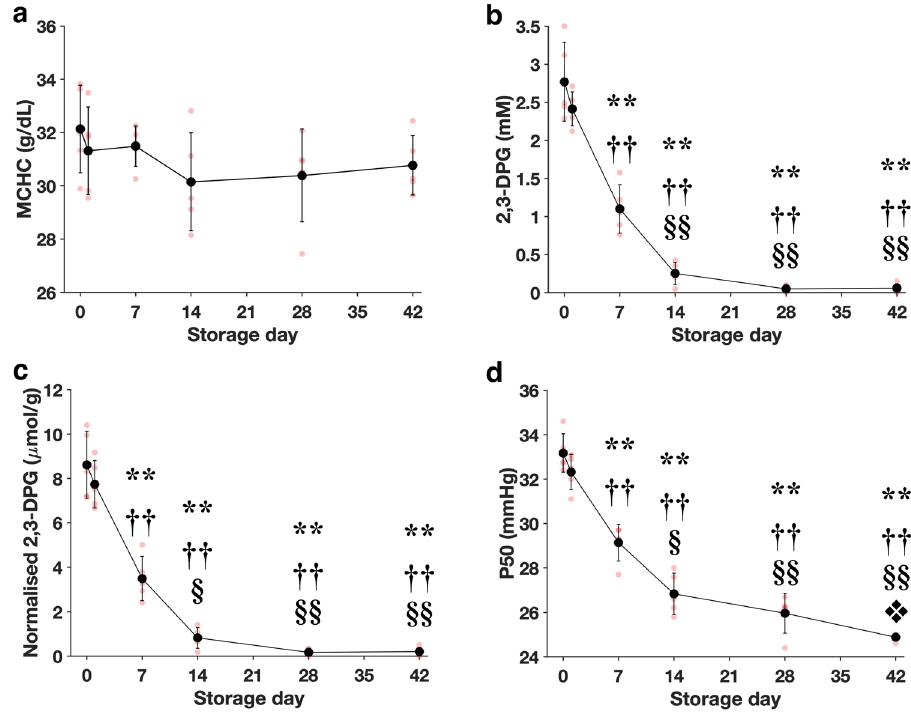
Fig. 3 Effect of in vitro aging during blood storage on O 2 af fi nity of RBCs. a – d MCHC, absolute 2,3-DPG concentration, normalized 2,3-DPG, and P50 during the storage period. All the results are based on bulk sample measurements ( n = 5 of biologically independent samples). The signi fi cant difference relative to Day 0: * P < 0.05, ** P < 0.0001. The signi fi cant difference relative to Day 1: † P < 0.01, †† P < 0.0001. The signi fi cant difference relative to Day 7: § P < 0.001, §§ P < 0.0001. The signi fi cant difference relative to Day 14: ❖ P < 0.01. Error bars correspond to the standard deviation of the